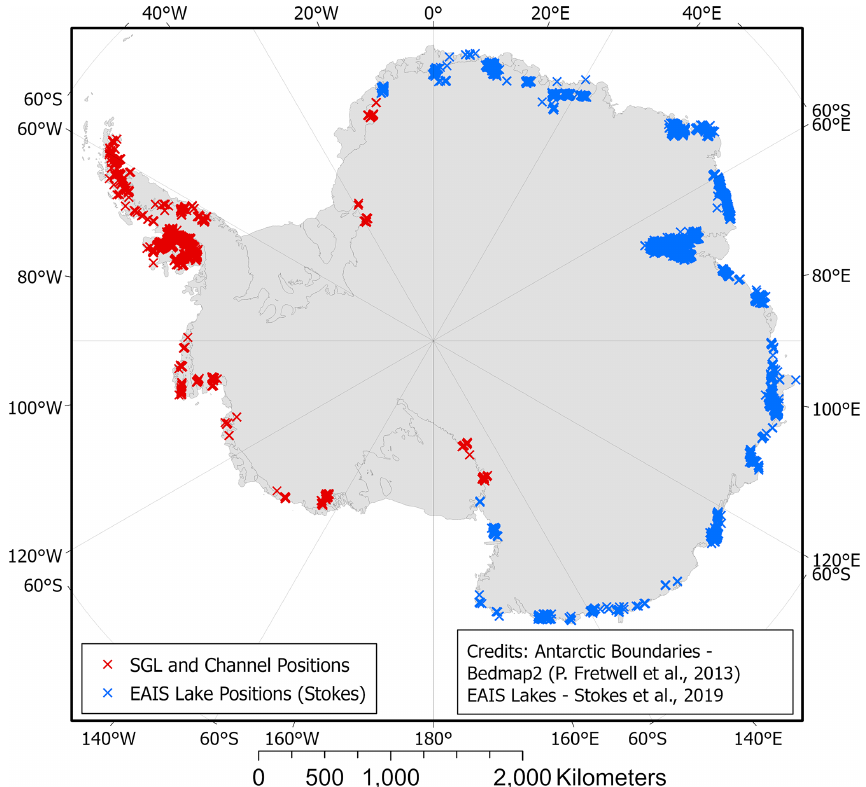
Figure 11. The location of the 10478 SGLs and channels on the WAIS and AP (red crosses) and 65459 SGLs (blue crosses; mapped by Stokes et al., 2019) in January and February 2017. Antarctic boundaries are according to Bedmap2 (Fretwell et al.,